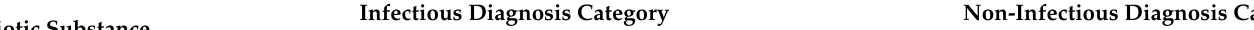
Table 4. DDD / 1000 patients for the most prescribed antibiotic substances (DU90%) at category and group level in the Obstetrics and Gynaecology departments of two private-sector hospitals, the TH and the NTH, in Central